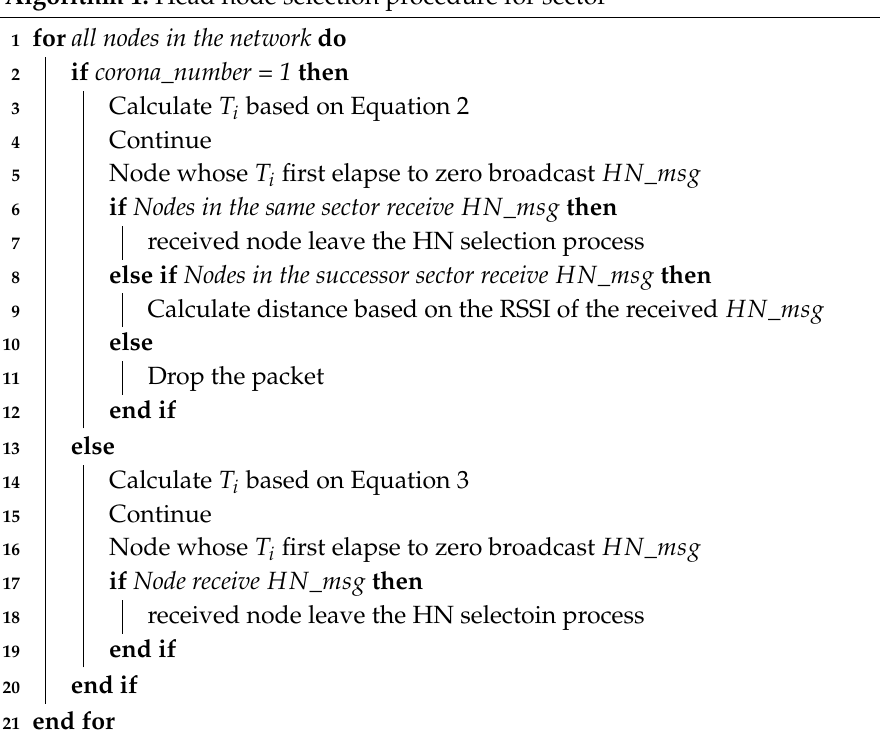
Algorithm 1: Head node selection procedure for sector